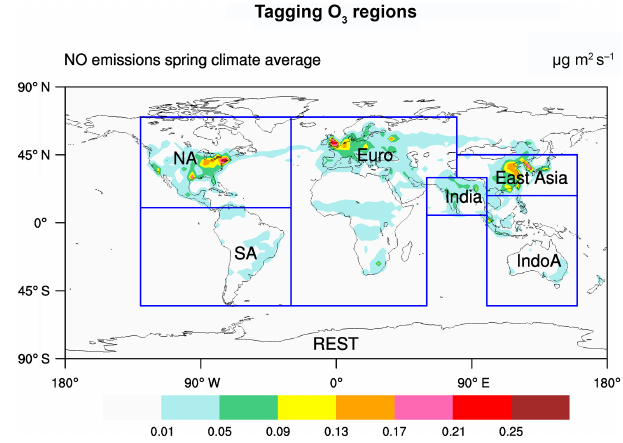
Figure 8. Regional separation for tracer tagging with distributions of the spring mean emission rate (µgm − 2 s − 1 ) of NO (including anthropogenic, biomass burning, and soil emissions) at the surface used in the model simulations during